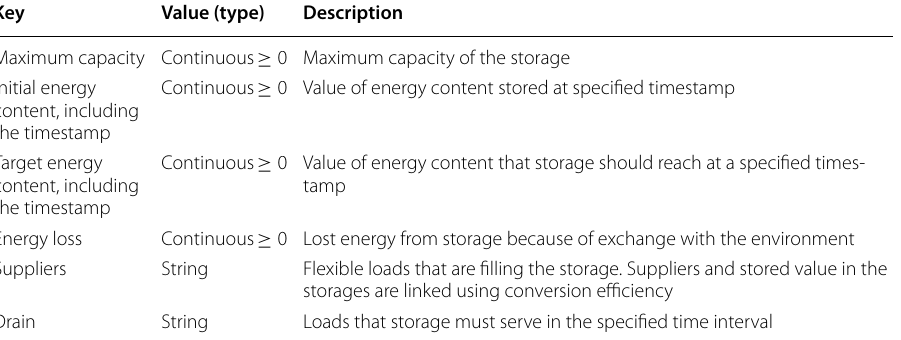
Table 2 Storage key figures of the EFDM as used by the optimization model Key Value